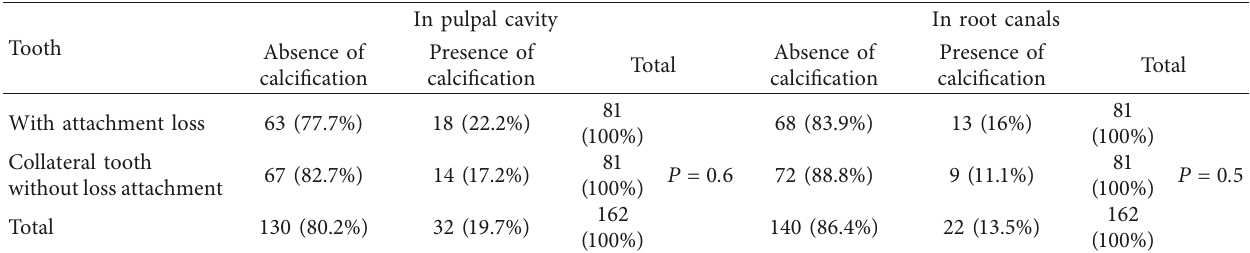
Table 4: Association between the presence of intrapulpal calcifications and attachment loss.